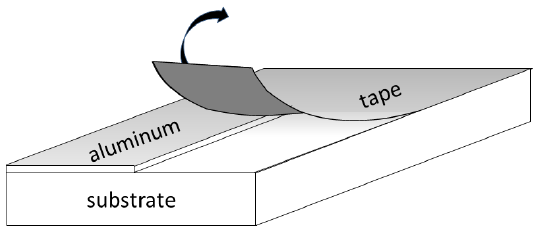
Figure 14. AFM measurement surface.